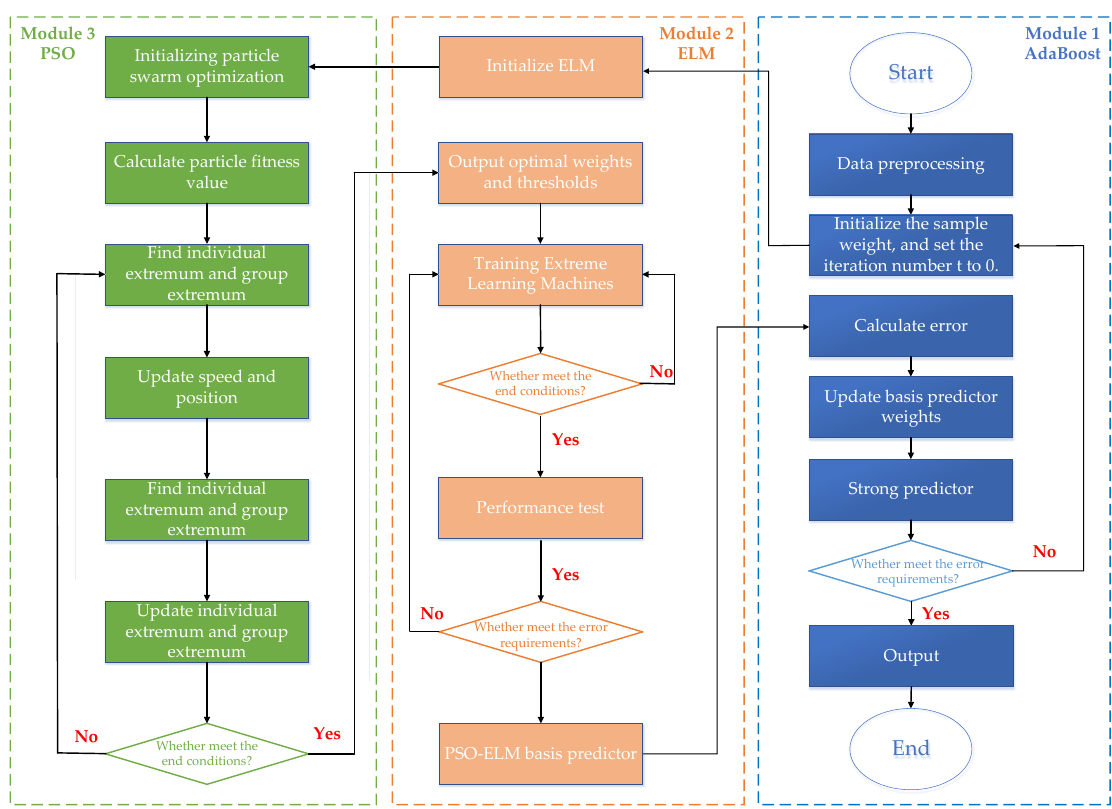
Figure 4. Framework Flow Chart of AdaBoost Particle Swarm Optimization Extreme Learning Machine (PSO-ELM) Integrated Learning.